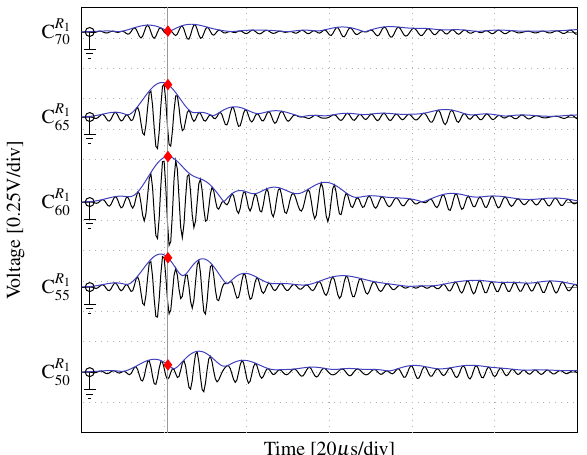
(in black) along with their envelopes (blue curves) Figure 8. Ultrasonic signals acquired in C R 1 i and the corresponding time of flight of the measured maximum amplitude (in gray lines and red marks,